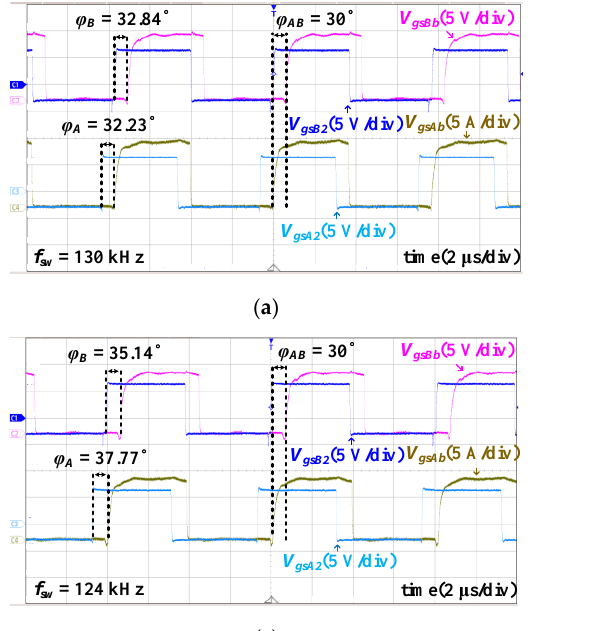
Figure 24. Phase shift waveforms of modules A and B at ( a ) 25%, ( b ) 50%, ( c ) 75% and ( d ) 100% loads. Table 3. The output current error of two modules.